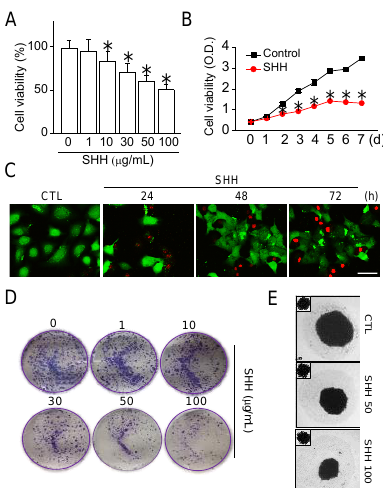
Figure 5. SHH-induced inhibition of A549 cell growth. ( A ) concentration-dependent e ff ect of SHH on cell viability. Cells were exposed to SHH (1, 10, 30, 50, or 100 µ g / mL) for 48 h. Each bar is the mean ± SD obtained from seven independent experiments ( n = 7). * p < 0.05 compared to the control. ( B ) Cell growth reduced by SHH treatment in a time-dependent manner. A549 cells were cultured in the presence or absence of SHH (100 µ g / mL) for 7 days. The cell viability was analyzed at the indicated time. Each data is the mean ± SD obtained from eight independent experiments ( n = 8). * p < 0.05 compared to each corresponding control. ( C ) SHH-induced cell death. Time-dependent increase in the number of dead cells. Live and dead cells are displayed in green (carcein) and red (propidium iodide, PI), respectively. Scale bar, 50 µ m. ( D , E ) Colony formation ( D ) and spheroid growth ( E ) of A549 cells inhibited by SHH. Cells were exposed to di ff erent concentrations of SHH for 2 days in the colony formation assay and for 10 days in the spheroid growth assay. In the spheroid formation assay, the small square in the upper left coner shows the size of speroids on day 4 of culture before SHH treatment. Scale bar, 50 µ m. Four independent experiments were performed ( C , D , E ; n = 4).